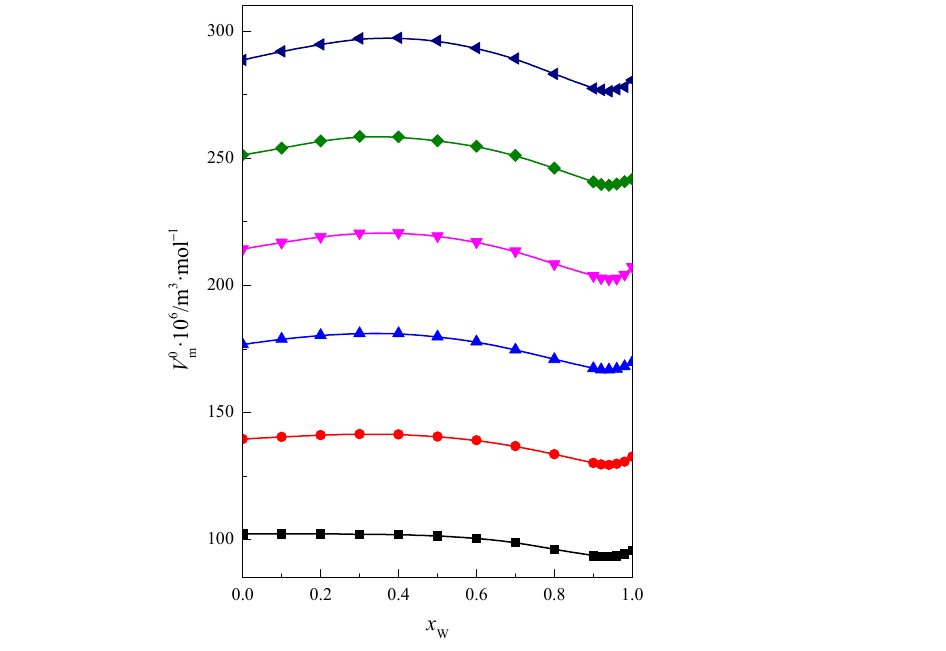
Figure 1. Limiting partial molar volume of solute in the DMF + W mixed solvent at 298.15 K: ■